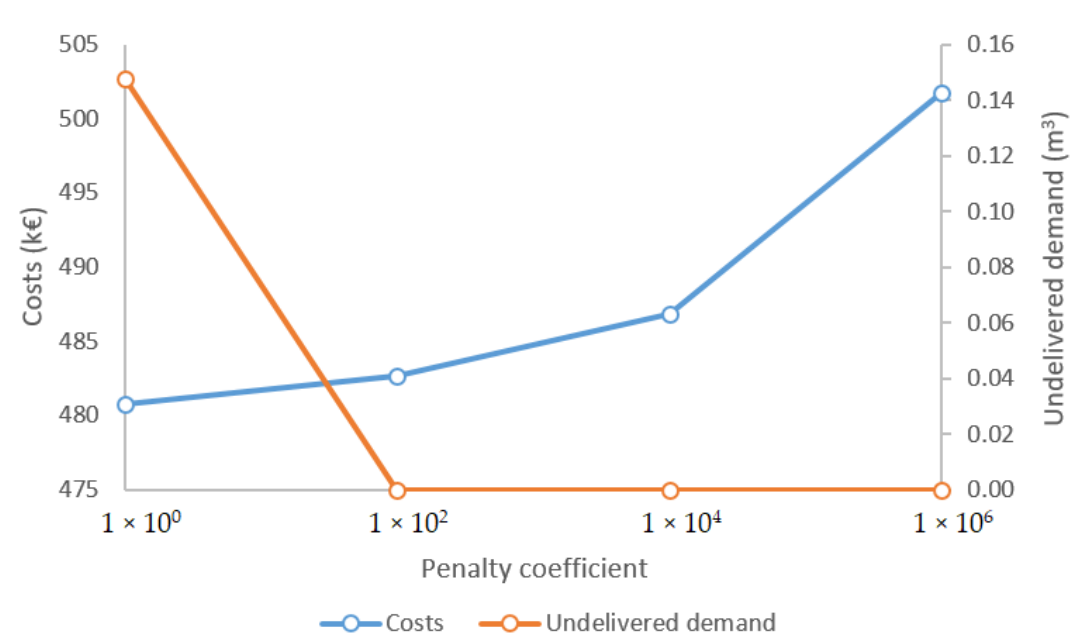
Figure 8. Relation between the design costs (axis y1 , blue curve) and the total undelivered demand (axis y2 , in m 3 during peak hour, orange curve,) for different values of the penalty coefficient ( Cpen ) in the optimization model when taking future demand scenarios into consideration. Fully satisfying demand under all future scenarios requires higher investment costs in the network.